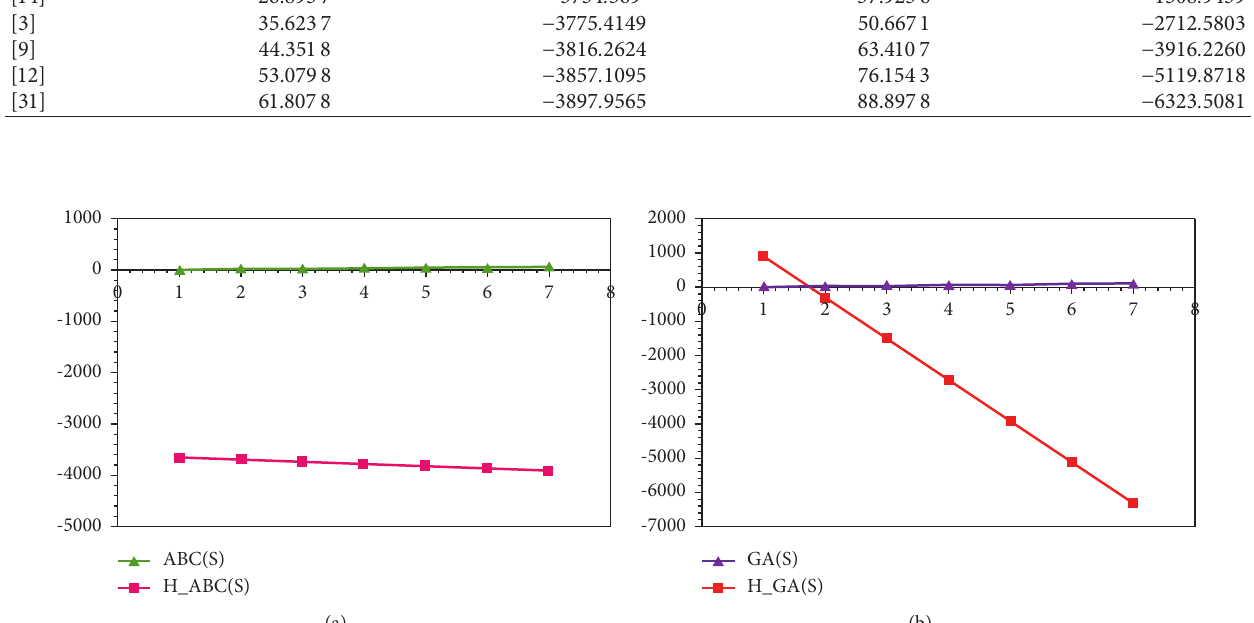
Figure 5: (a) The ABC index with heat of formation (b) The GA index with heat of formation.